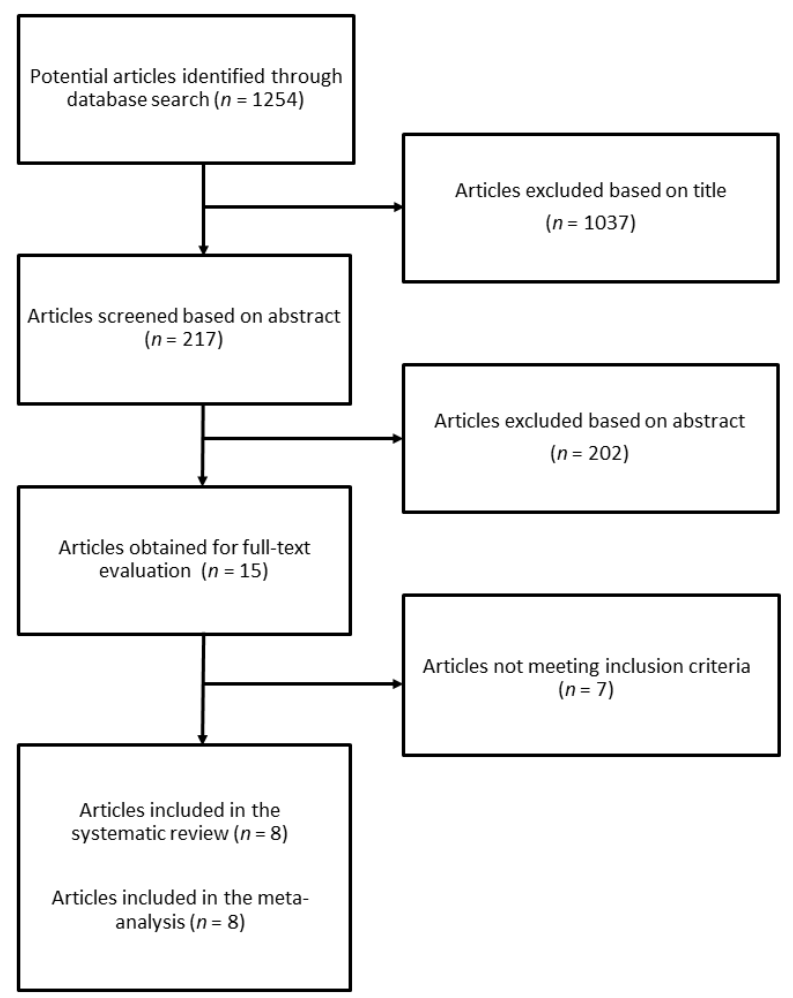
Figure 1. Process selection of relevant studies reporting on the association between simple scores of fibrosis and mortality in NAFLD patients.